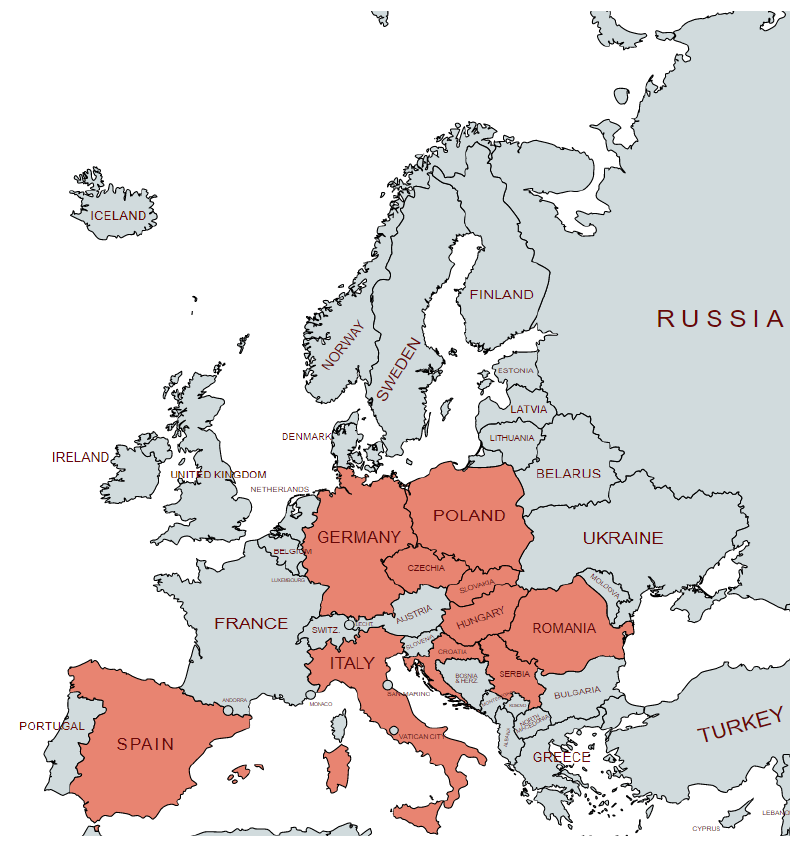
Figure 1. Occurrence of Babesia gibsoni in Europe.